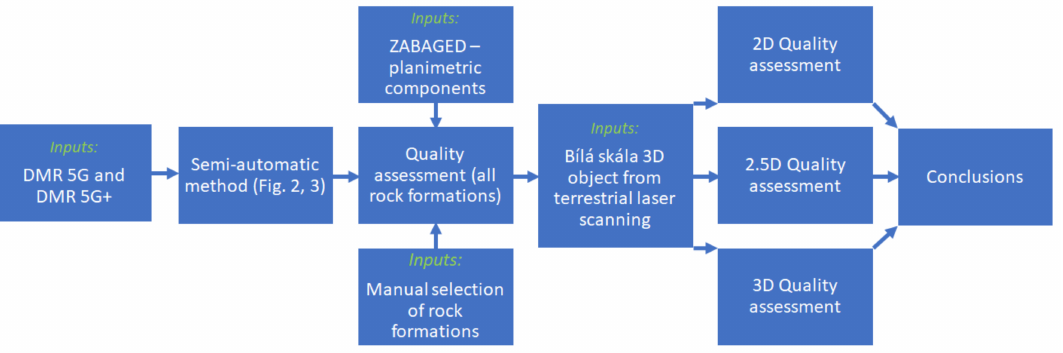
Figure 1. Workflow showing identification and quality assessment of rock surfaces from digital terrain model (DTM)